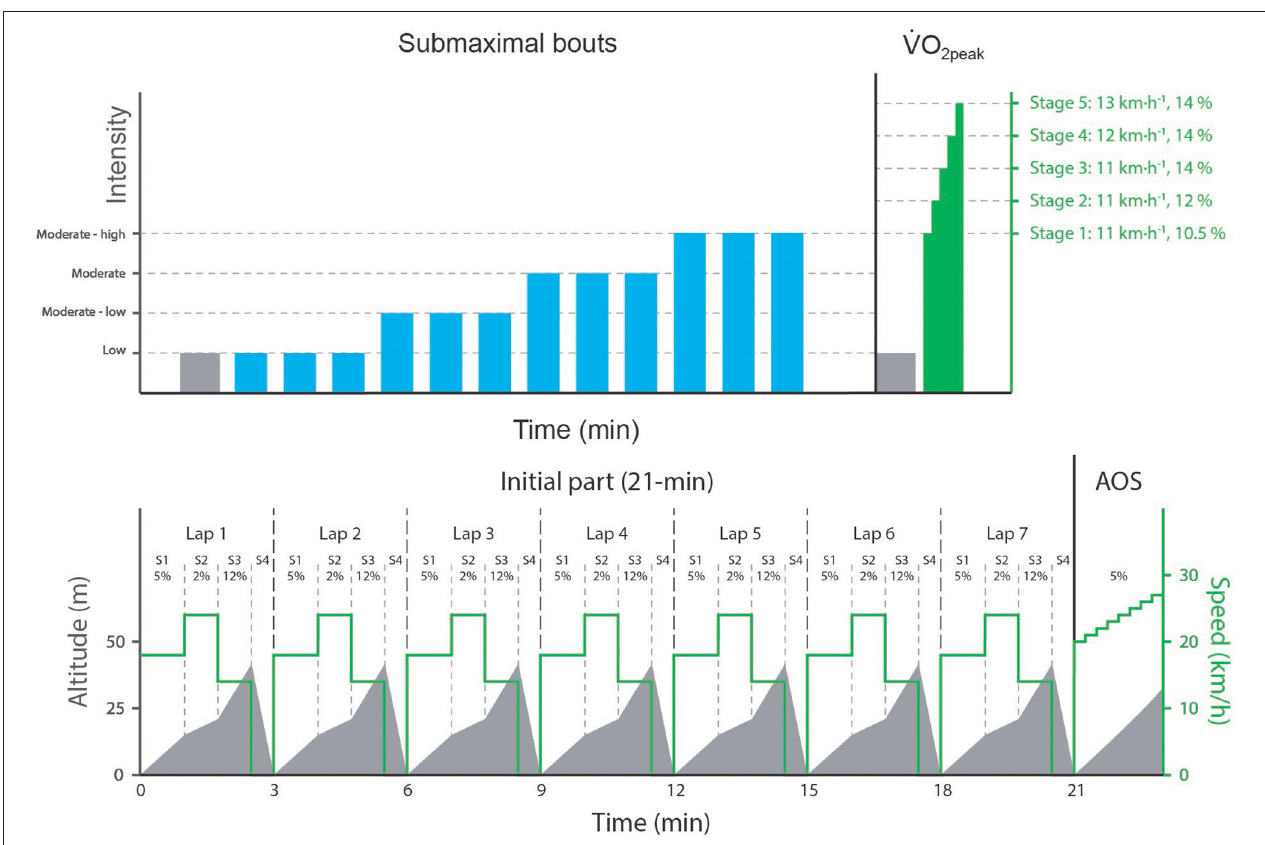
FIGURE 1 | The protocol of the first (upper part of the figure) and second (lower part of the figure) experimental testing day. The three different exercise bouts at the same intensity represent the exercise bouts using either G2, G3 or G4, which were performed in random order. ˙ VO 2peak , peak oxygen uptake; S, segment; AOS, all-out sprint. Figure adapted from Seeberg et al.